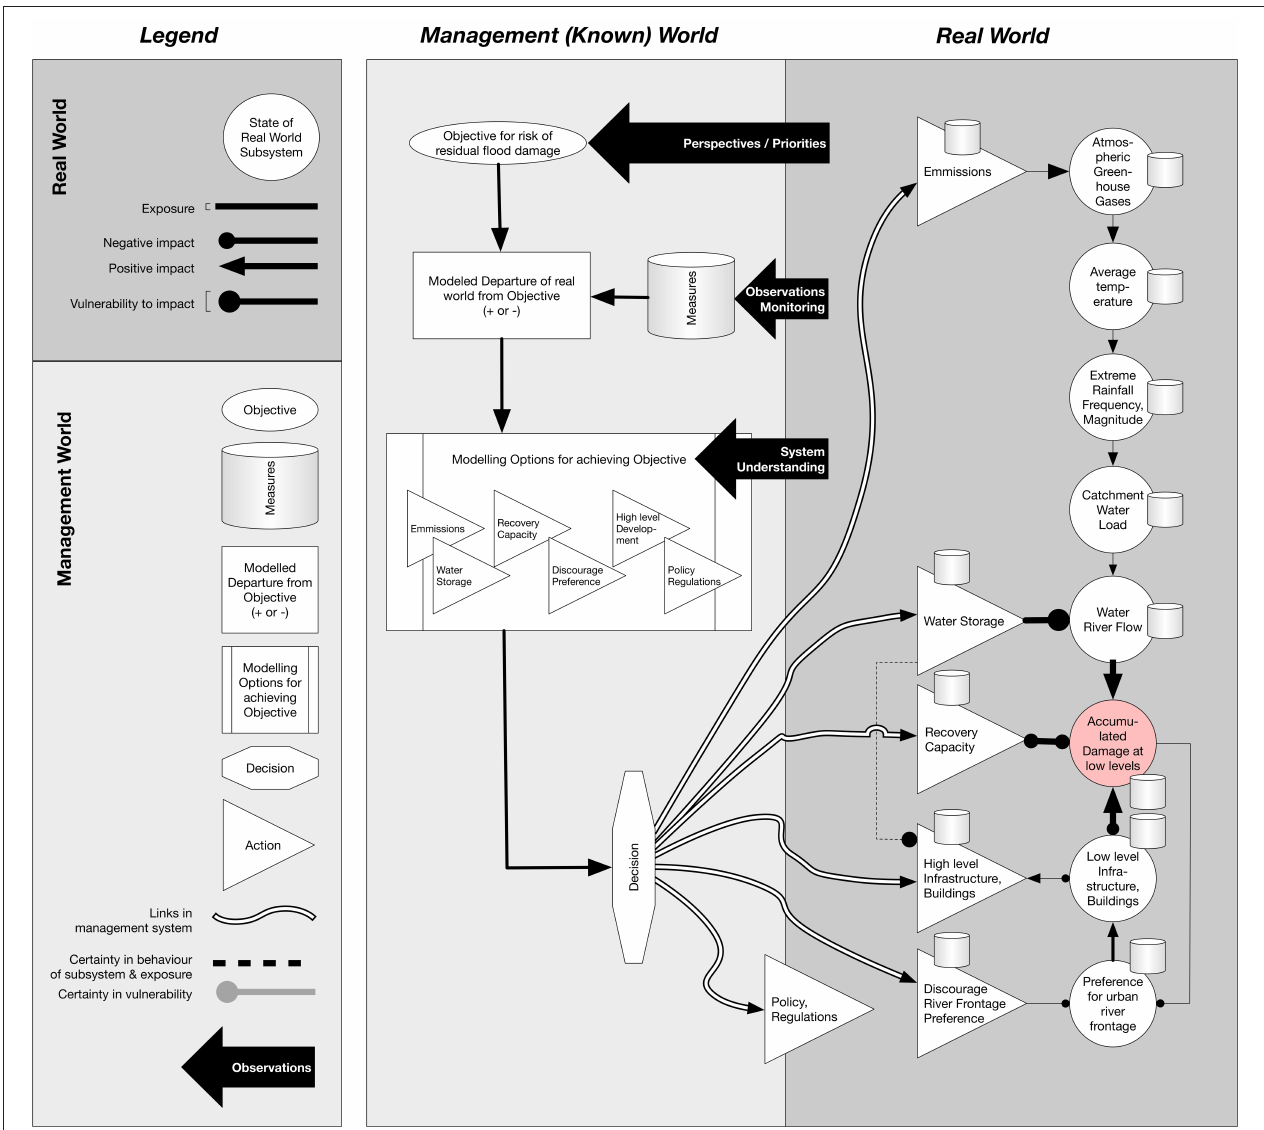
FIGURE 3 | Example system managing risk of accumulated damage (red circle) of low level areas prone to flooding in the real world ( Box 2 ). Each of the subsystems in the real world have a dynamic affected by internal drivers as well as the external inputs and outputs from other subsystems. The relationships (edges) between subsystems (nodes) and their effects on each other are mapped using a digraph. An end of an edge has an arrow (positive relationship), circle (negative relationship) or neither (no relationship), which indicates how the abutting subsystem will change when the subsystem at the other end of the edge changes. A positive relationship means the affected subsystem will change in the same direction as the impacting subsystem, and a negative relationship means the affected subsystem will change in the opposite direction. These subsystems may also be influenced by other Earth subsystems, human activities and/or management systems not illustrated here. Knowledge of the real world is constrained to the three black arrows. Interventions of the management system in the real world are through actions, which may in themselves be